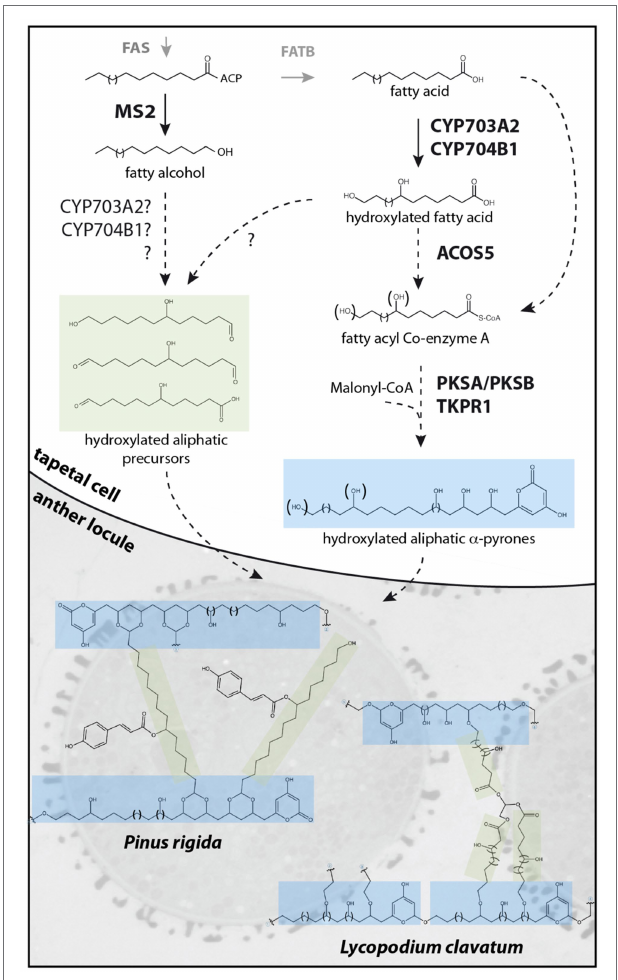
FIGURE 1 | Proposed sporopollenin metabolic pathway and simplified molecular structures of Pinus rigida and Lycopodium clavatum sporopollenin. Fatty acyl-ACP esters, synthesized de novo by the FAS complex, are reduced by MS2 to produce fatty alcohols or hydrolyzed by FATB to produce free fatty acids. After hydroxylation by CYP703A2 and CYP704B1, free fatty acids may be reduced by unknown reductases to fatty alcohols or aldehydes, forming putative hydroxylated aliphatic sporopollenin precursors. Alternatively, hydroxylation by CYP703A2 and CYP704B1 of the fatty alcohol produced by MS2 may occur. In the case of Pinus rigida , these aliphatic precursors might be acylated with phenolics by an unknown transferase. Hydroxylated or non- hydroxylated fatty acids are esterified to CoA by ACOS5 prior to several cycles of condensation by PKSs and reduction by TKPRs to form polyhydroxylated α -pyrone precursors. The precursors could be exported to the anther locule and polymerized on the surface of developing microspores by an unknown mechanism. In Pinus rigida , a simplified sporopollenin is proposed to predominantly contain hydroxylated aliphatic α -pyrone units, crosslinked at one end through an ester group and linked through a dioxane moiety to other units by a hydroxylated aliphatic chain bearing a coumaroyl moiety. In Lycopodium clavatum , the sporopollenin structure is proposed to contain a rigid macrocyclic backbone of several hydroxylated aliphatic α -pyrone units coupled through ether bonds to hydroxylated aliphatic networks linked together by